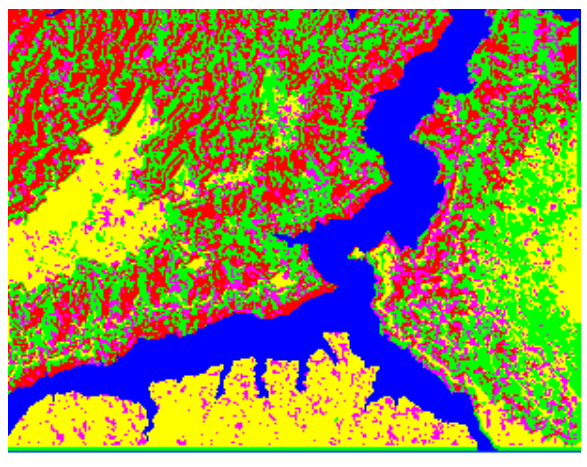
Figure 24. Forecast result of Minimum Distance.